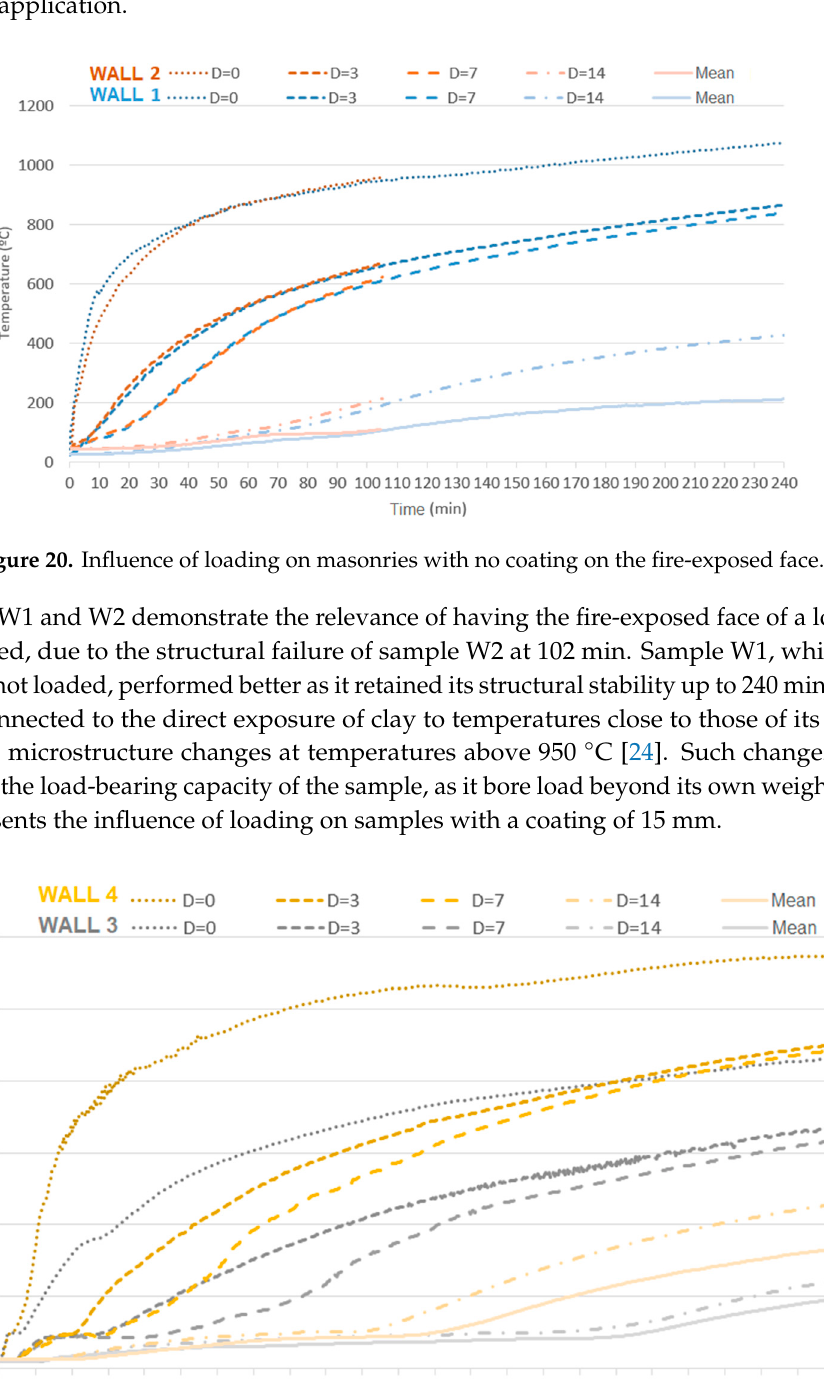
exposed face, without (W3) and with (W4) application of load.